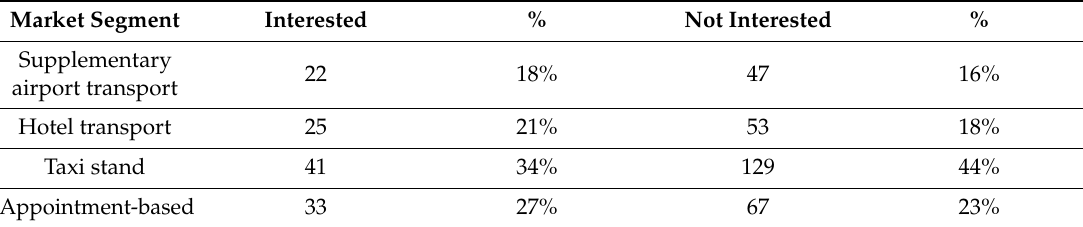
Table 3. Market segments.